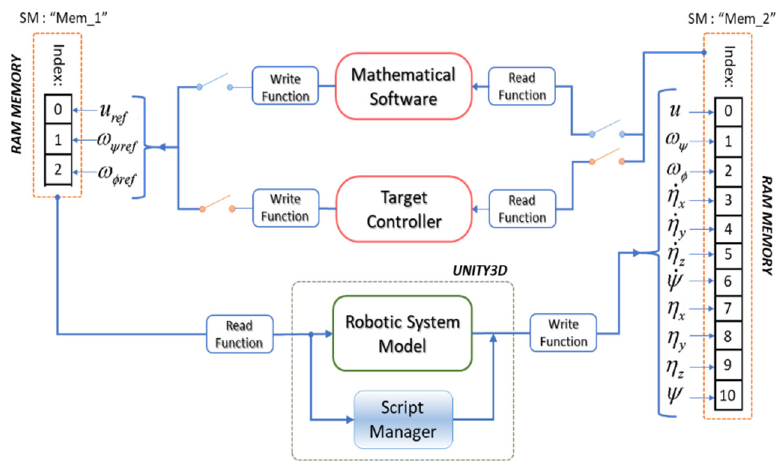
Figure 12. Publisher/subscriber of the shared memories.